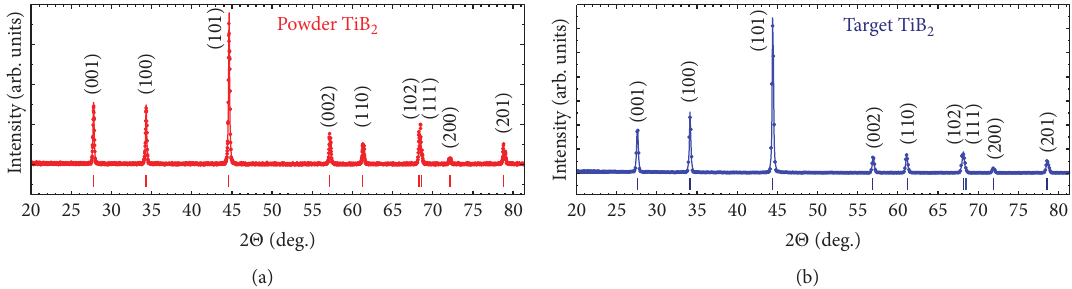
Figure 3: X-ray diffraction spectra of (a) powder (H. C. Starck, Germany) and (b) bulk (target, Goodfellow, UK) samples of titanium diboride (TiB 2 ). Experimental data and the Rietveld refinement are represented by symbols and curves, respectively. Small vertical lines indicate positions of the Bragg peaks corresponding to the TiB 2 phase. The XRD peaks are indexed according to the reference 04-010-8469 [27].